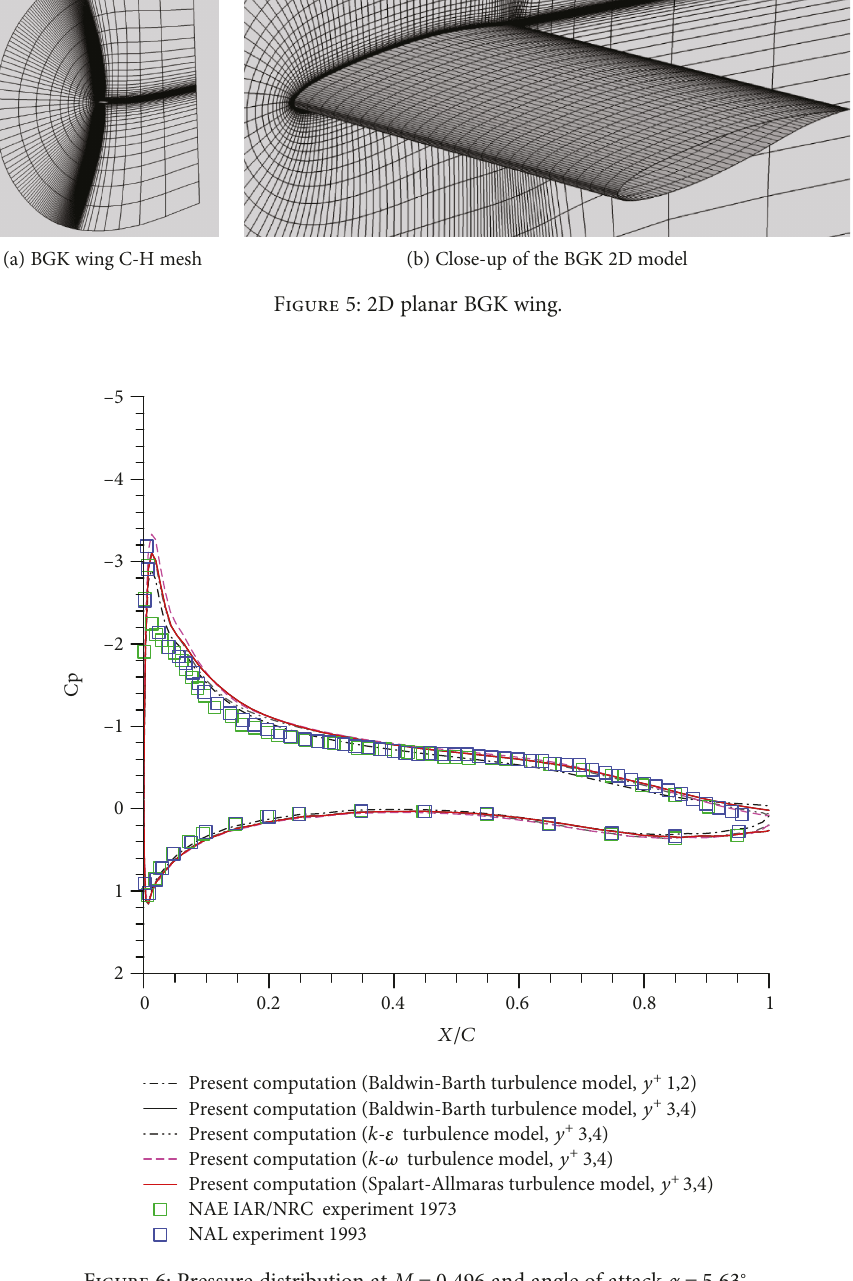
Figure 6: Pressure distribution at M = 0 496 and angle of attack α = 5 63 °